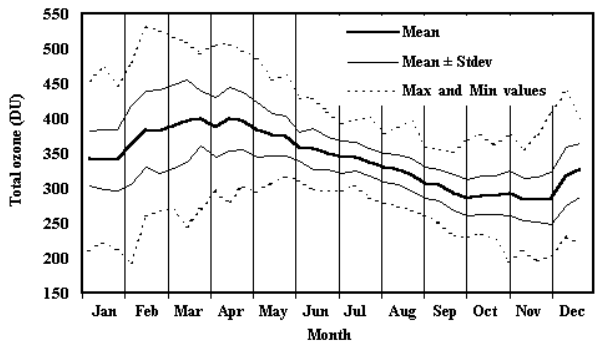
Fig. 1. Annual mean cycle of total ozone over Estonia 1979–2000 based on TOMS averaged ten-day values, (1983, 1992 and 1993 excluded).